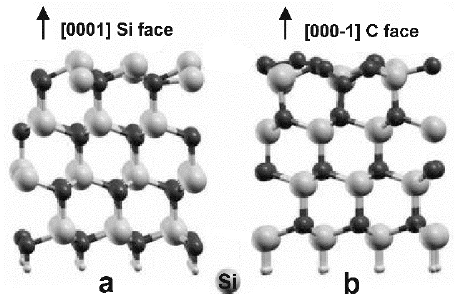
Figure 12. Schematic drawing of the SiC polar structures: ( a ) Si face, ( b ) C face.